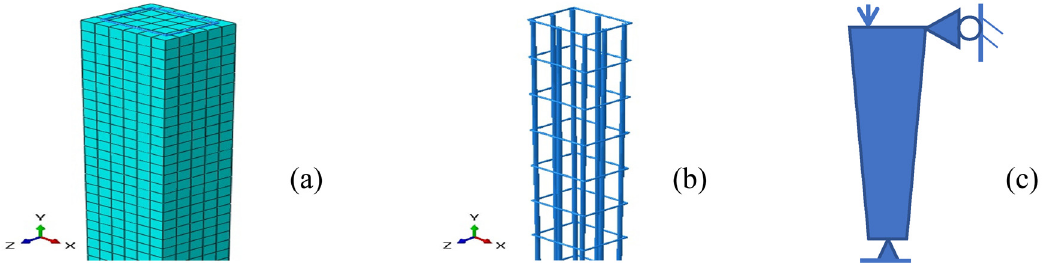
Figure 2: ( a ) Concrete elements, ( b ) reinforcement model, and ( c ) idealized column.